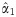
Evaluation of type I error rate and power for various colocalization analysis schemes in simulation studies.This exercise helps to evaluate the calibration of the reported RCPs from various analysis schemes. Better calibrated RCPs result in less conservative control of the type I errors and improved power. Note that the underestimation of α^1 results in noticeable, but not substantial, power loss. The results indicate that the RCPs are better calibrated for more accurate enrichment estimates and/or the use of multi-SNP analysis in GWAS.